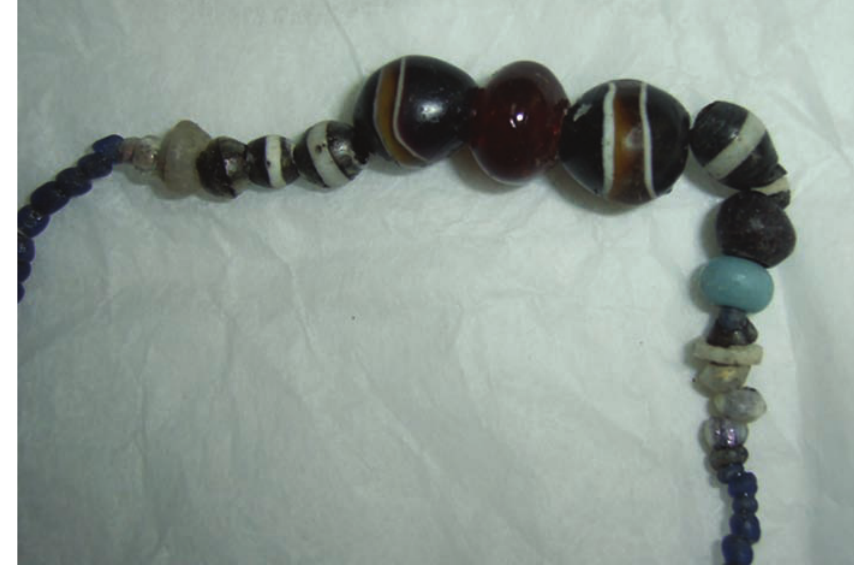
Figure 7 A restored necklace made up of beads recovered from the grave of the female individual shown in Figure